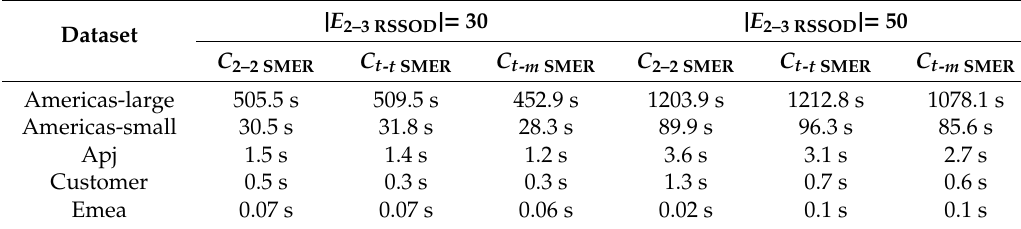
Table 12. Execution time with 2–3 RSSOD.